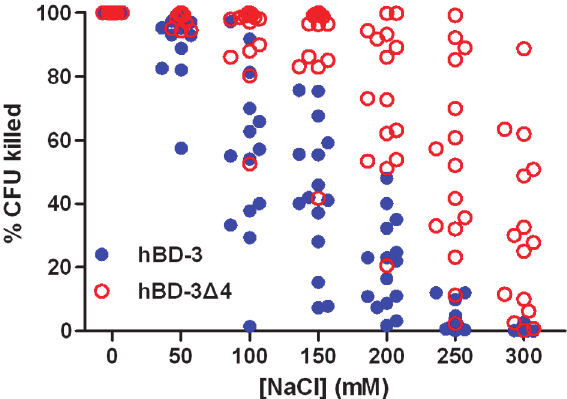
Fig 2. Antibacterial activity at increasing NaCl concentrations of hBD-3 and hBD-3 Δ 4 against fifteen E. coli clinical